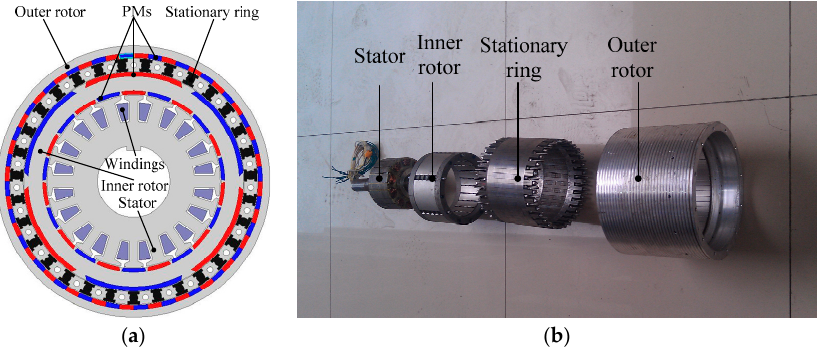
Figure 1. Existing machine: ( a ) cross section; and ( b ) prototype. PMs: permanent magnets.